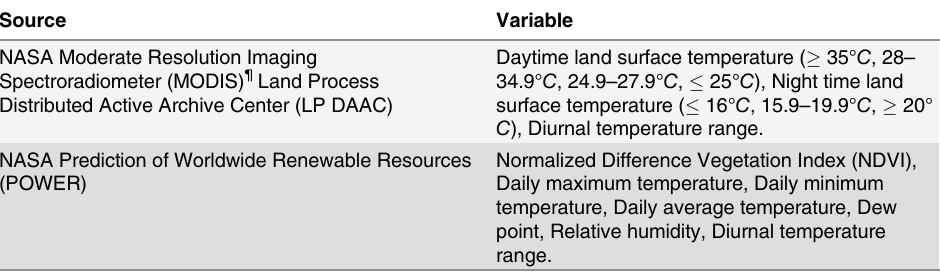
Table 2. Climate variables evaluated in the